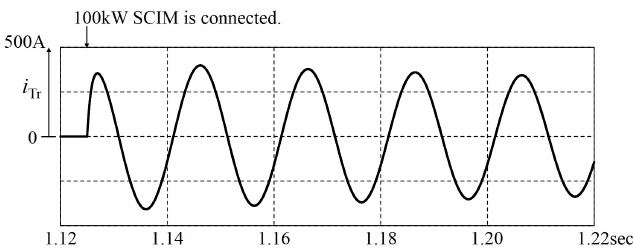
Figure 12. Source current for the 100-kW SCIM with the external resistors.